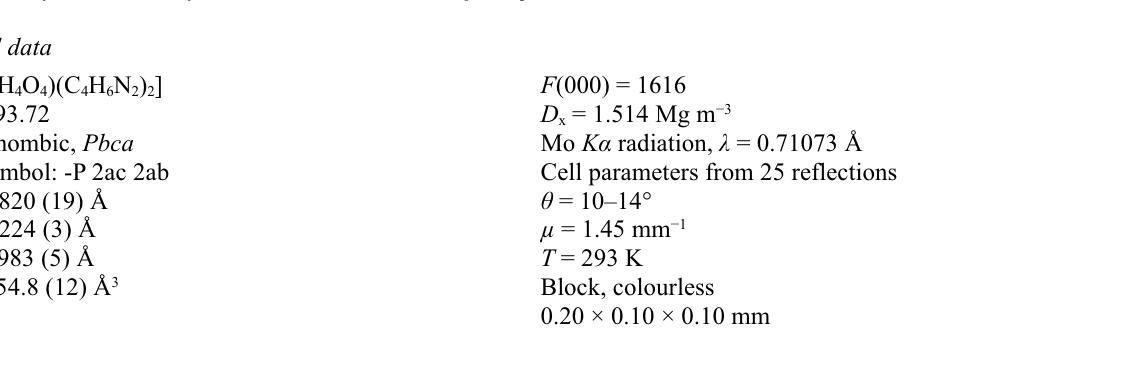
A portion of the polymeric chain in (I) showing the atomic numbering and 30% probability displacement ellipsoids. catena -Poly[[bis(1-methylimidazole- κ N 3 )zinc(II)]- µ -isophthalato- κ 2 O 1 : O 3